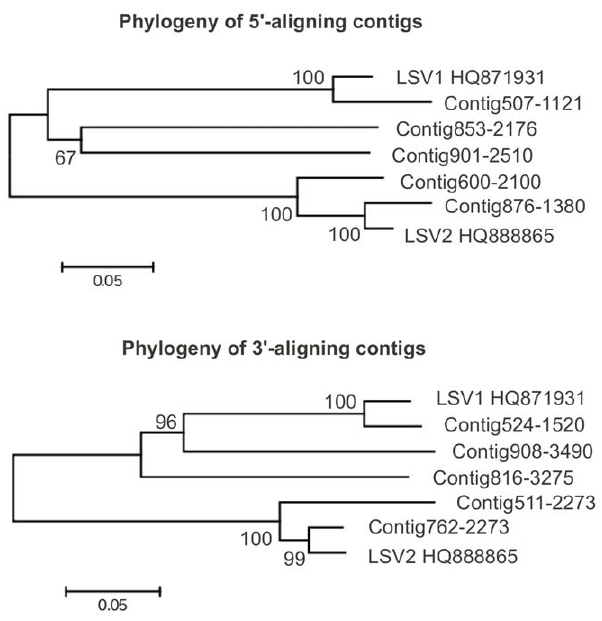
Figure 3. Phylogeny of contigs related to the Lake Sinai Viruses (LSV1 and LSV2). A . Phylogeny of the five longest 5 9 -aligning contigs with LSV1 and LSV2 (GenBank accessions HQ871931.1 and HQ888865.1) B . Phylogeny of the five longest 3 9 -aligning contigs with LSV1 and LSV2. The two trees have similar branch lengths and topologies, suggesting that a physical linkage between each 5 9 -aligning contig and a 3 9 - aligning contig.